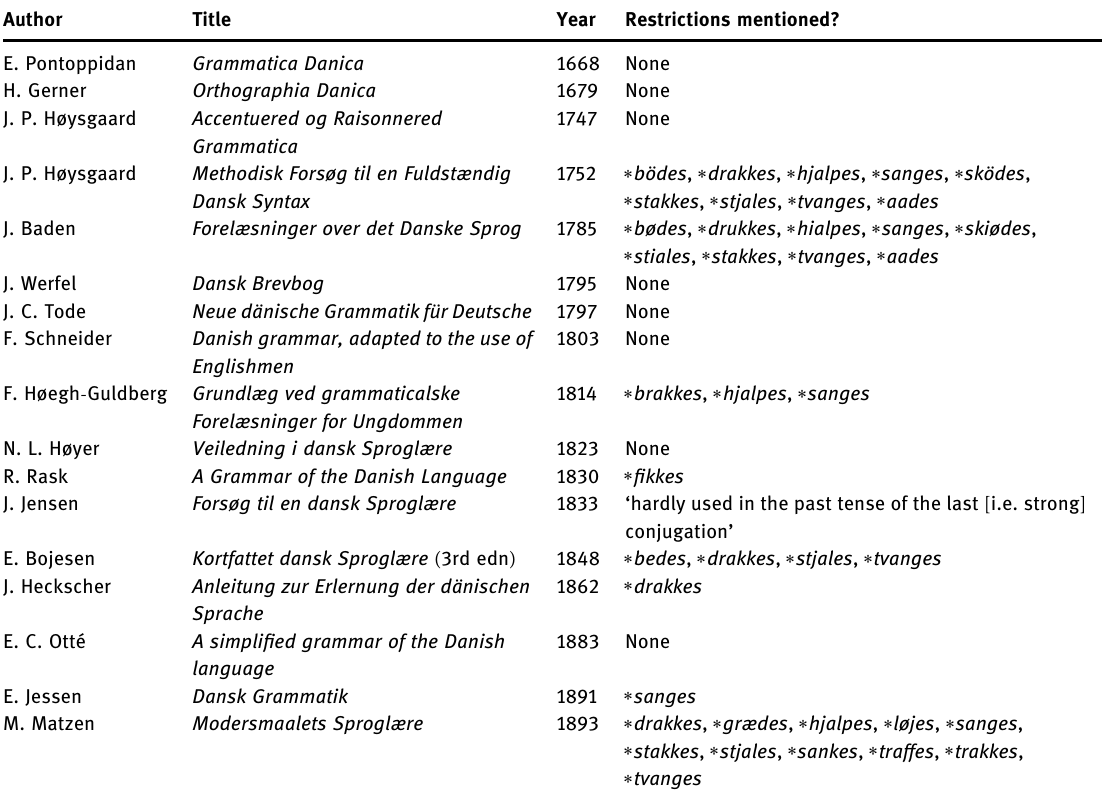
Table 4: Surveyed historical